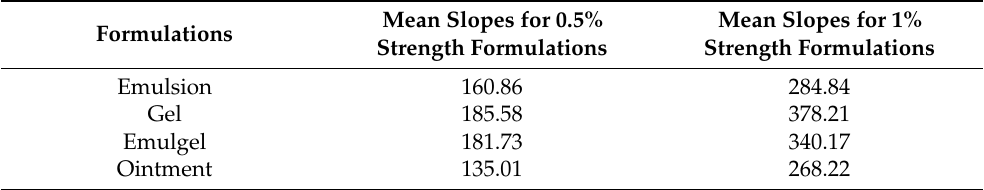
Table 7. Comparison of mean release rate (slope) values for different dosage strengths of semi-solid formulations containing diclofenac sodium.